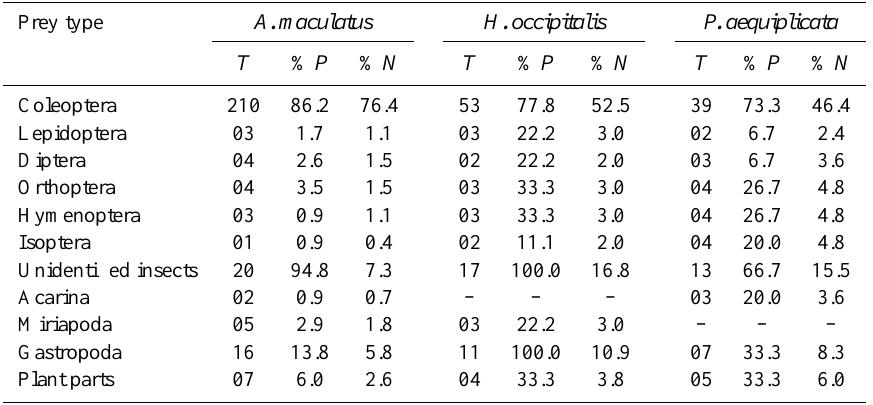
Table 4. Diet descriptors of the three anurans from Port Harcourt, Nigeria. Symbols: T = total number of prey items; % P = percentage of occurrence; % N = percentage of